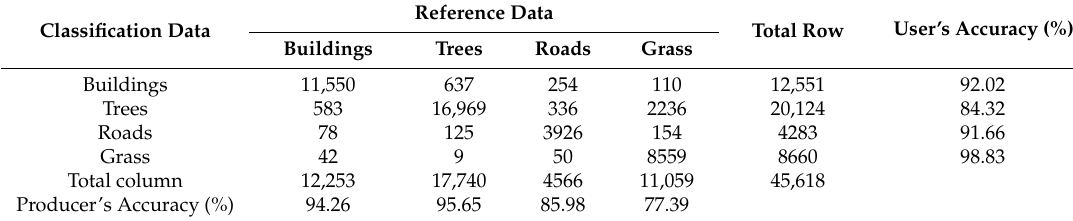
Table 4. Confusion matrix for CIBs_DSM.